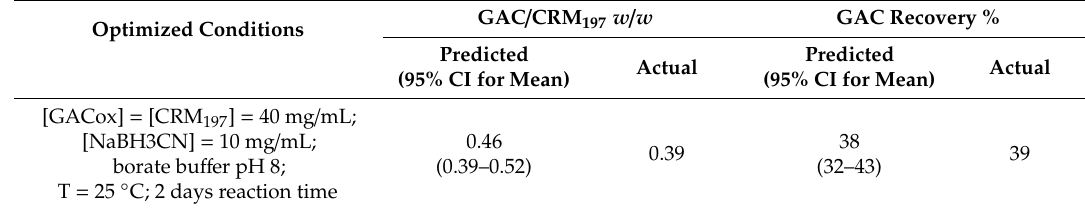
Table 2. Optimized conditions for GACox-CRM conjugation and predicted responses from the model, confirmed by performing an additional conjugation test.